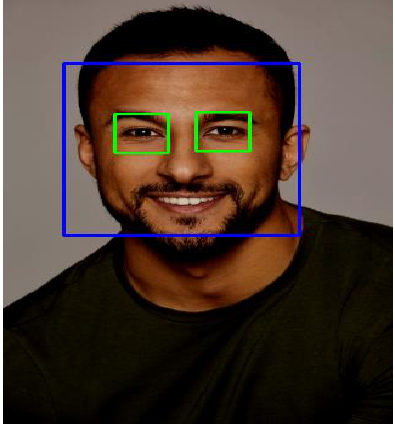
Figure 11. Considering the single face object.